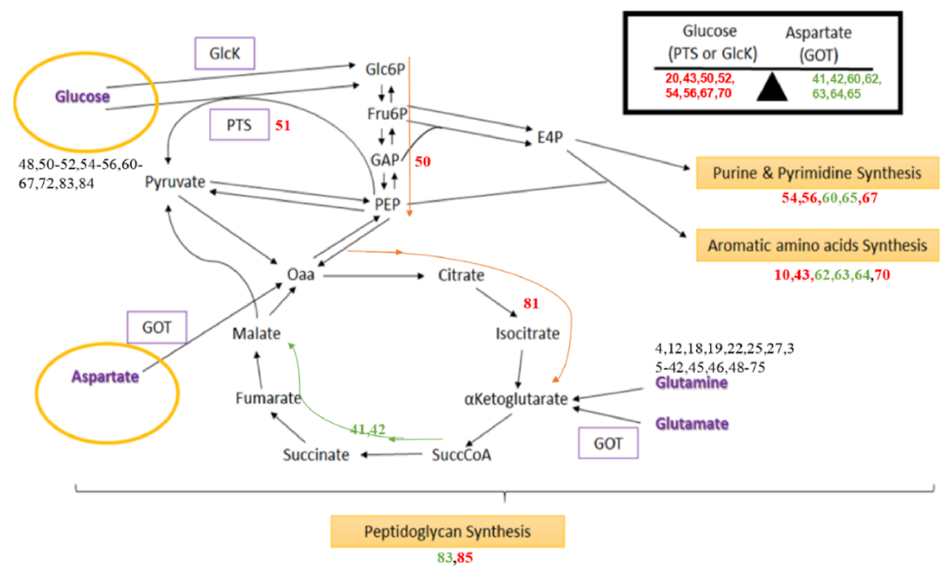
Figure 3. Different metabolic pathways are altered between the WT, ∆ pknB ∆ stp , ∆ pknB and ∆ stp . The three mutants are compared to the wild type. Shown is the central metabolism and how it is influenced by pknB . The corresponding textbook pathways are shown. Fluxes are indicated by ar- rows. All major (by flux strengths) EPMs that contribute to a specific textbook pathway in NewHG as calculated from the data are shown directly as labels for this textbook pathway. The numbering of the EPMs is given according to Table S3 in Supplementary File S3 (left column; followed by an abbreviated listing of the involved enzymes; next follows the input and output reaction catalysed by the EPM and on the right part the EPM flux activity compared in the wild type and mutants). The colour indicates an up- (green) or downregulated (red) EPM compared to the wild type. The pathways indicated include synthesis of peptidoglycan, nucleotide and aromatic amino acid and catabolism involving GOT.